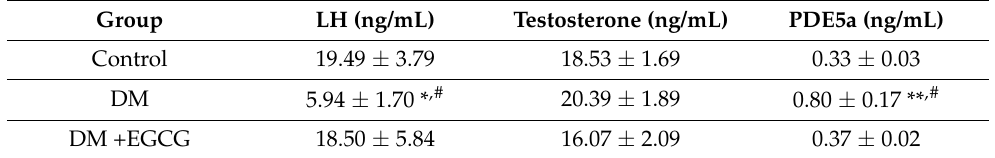
Table 1. Effect of EGCG on serum LH, testosterone, and PDE5a levels. Group